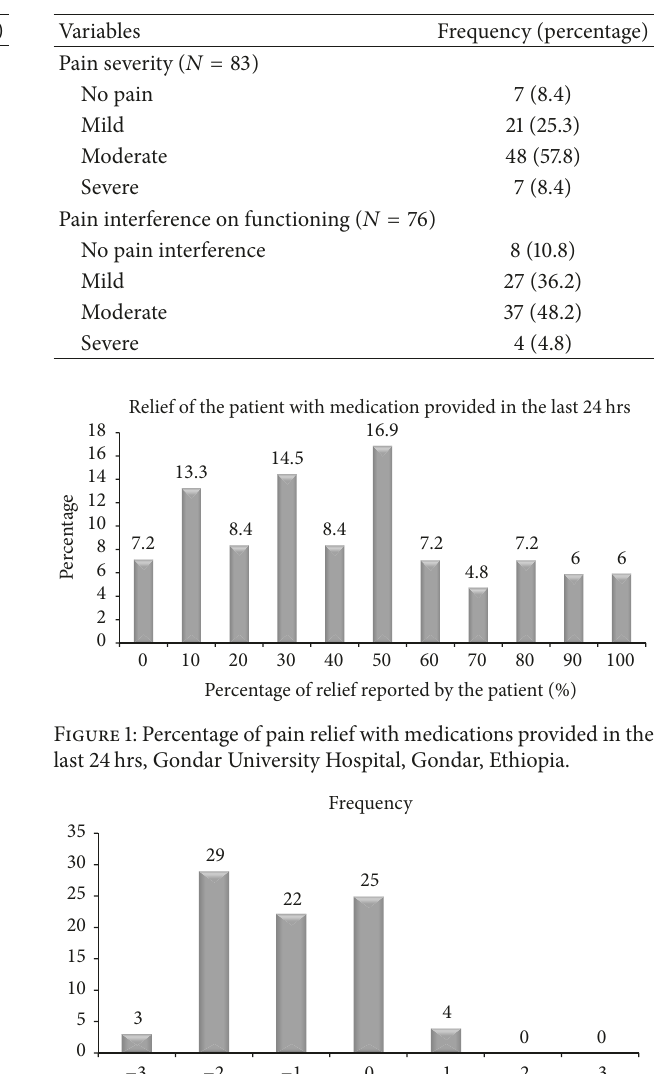
Table 1: Characteristics and clinical data of the study population in Oncology Department of Gondar University Hospital, Gondar, Ethiopia.